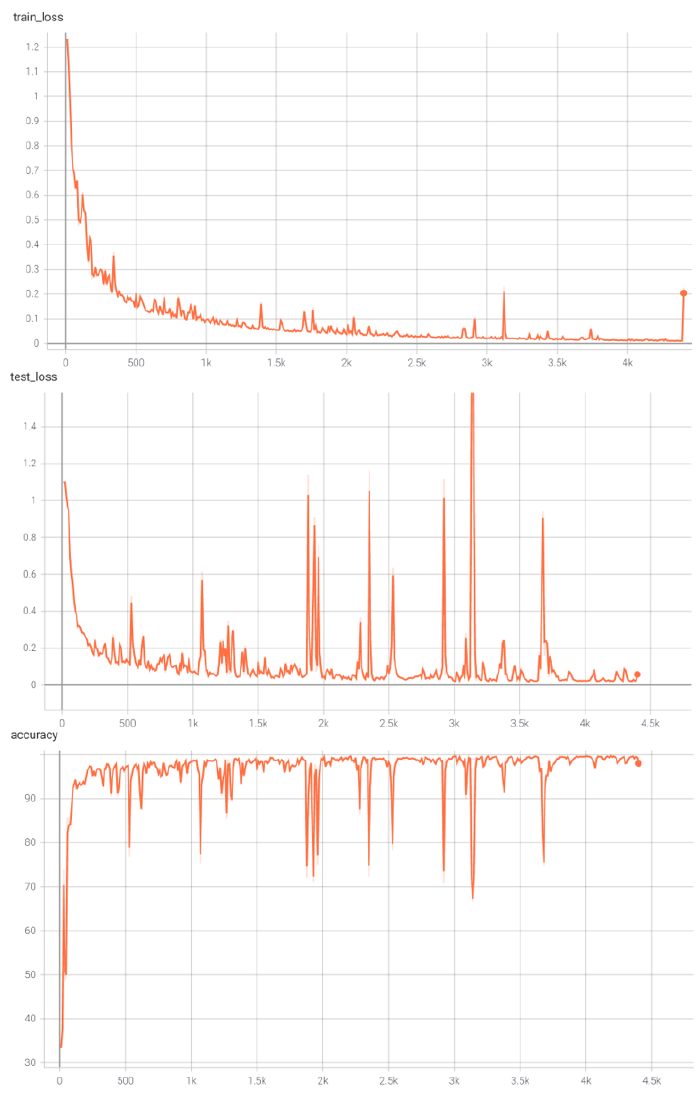
Figure 13. PointNet training curve (no learning rate decay).